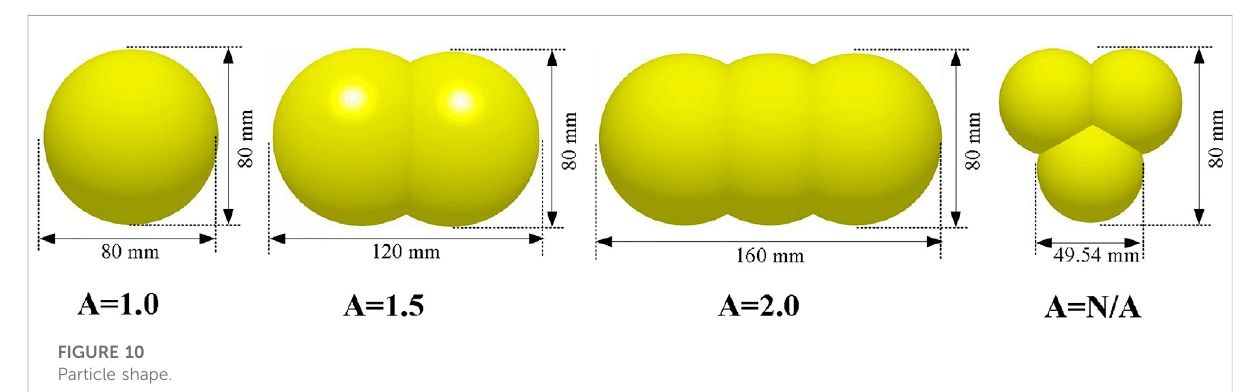
FIGURE 10 Particle